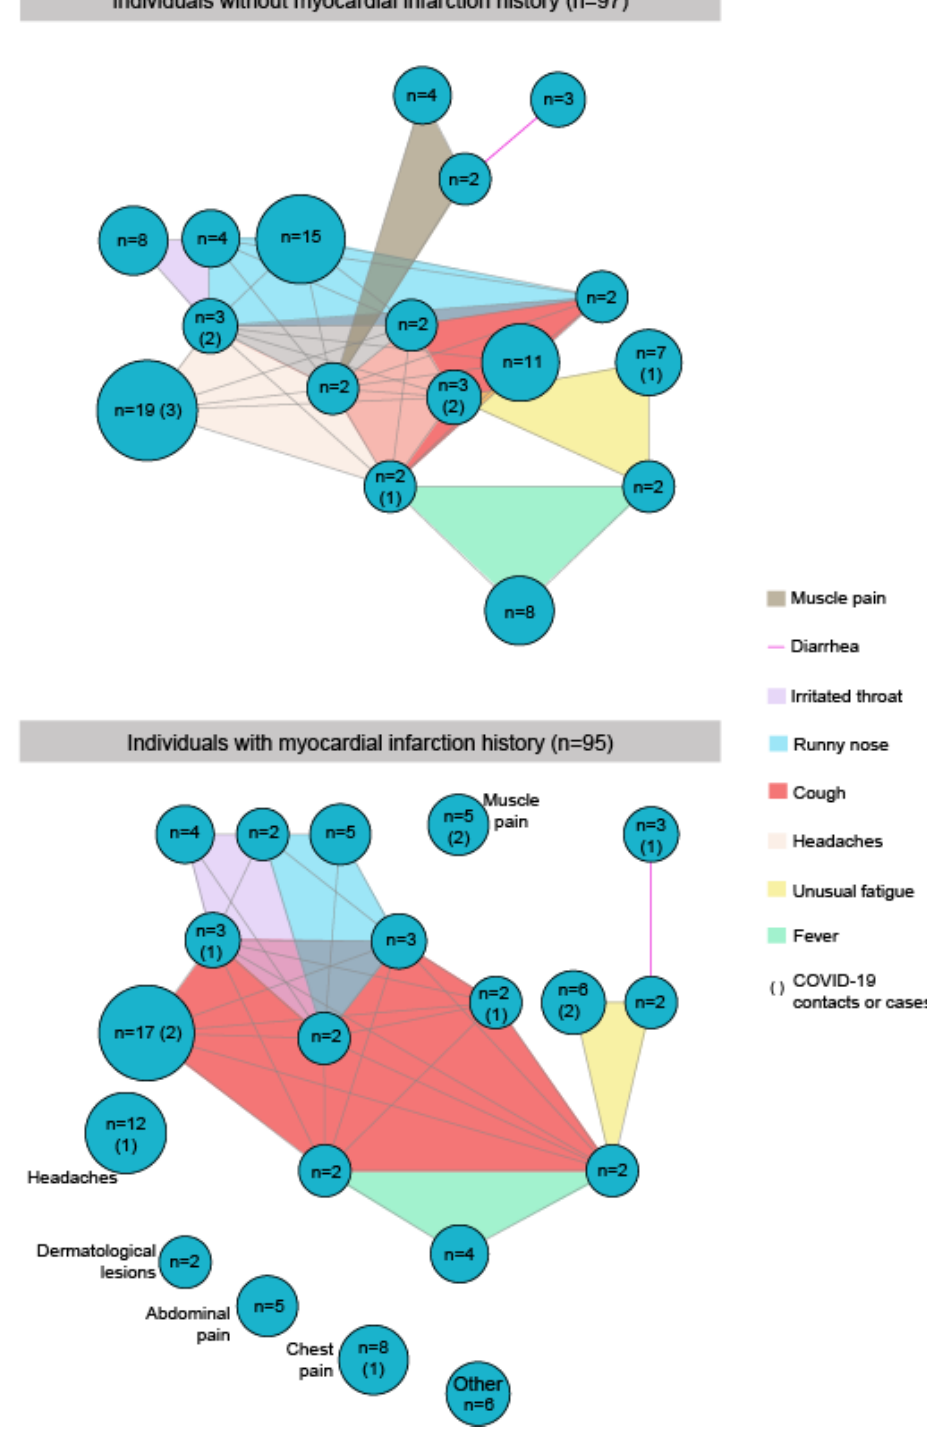
Figure 3. Symptom network of associations reported by at least two individuals: comparison of the reported clinical signs between individuals without myocardial infarction history (n=97) and with myocardial infarction history